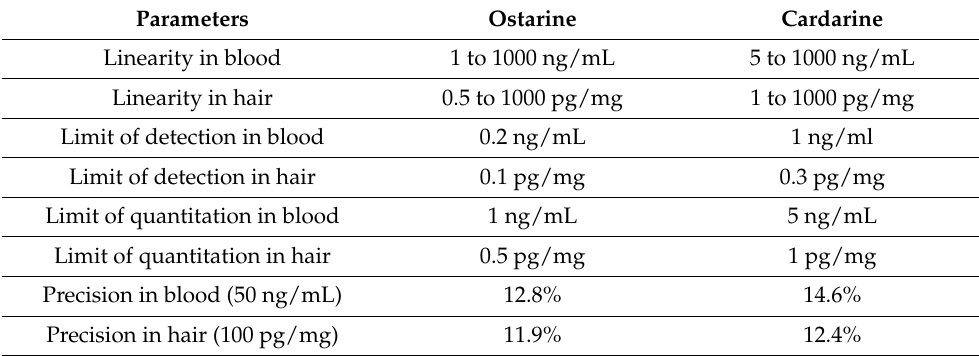
Table 2. Validation parameters in blood and